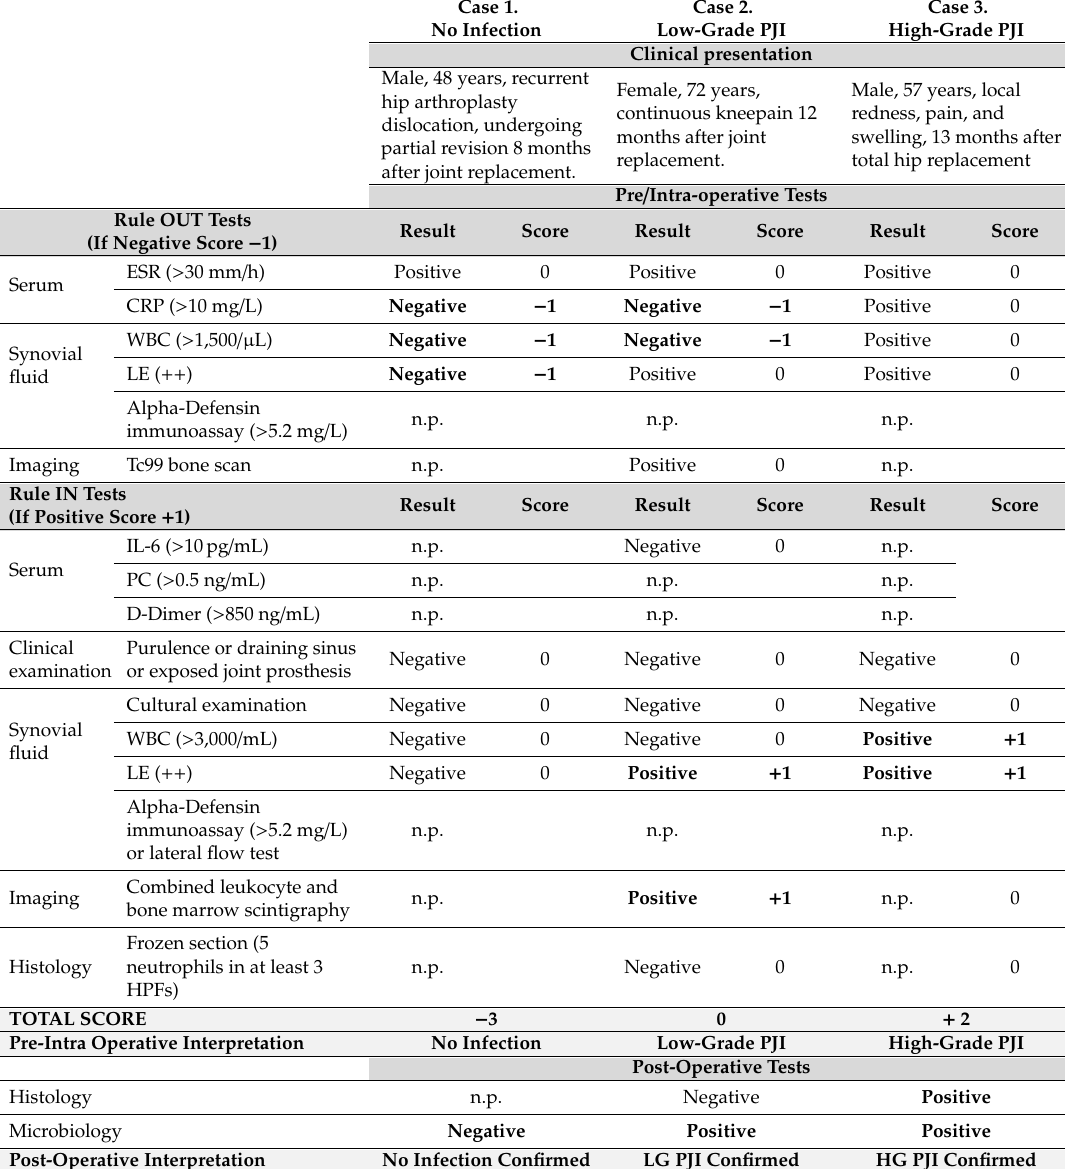
Table 4. Real case examples of diagnostic pathways, that can be used to confirm or exclude PJI, according to the WAIOT proposed definition (n.p.: not